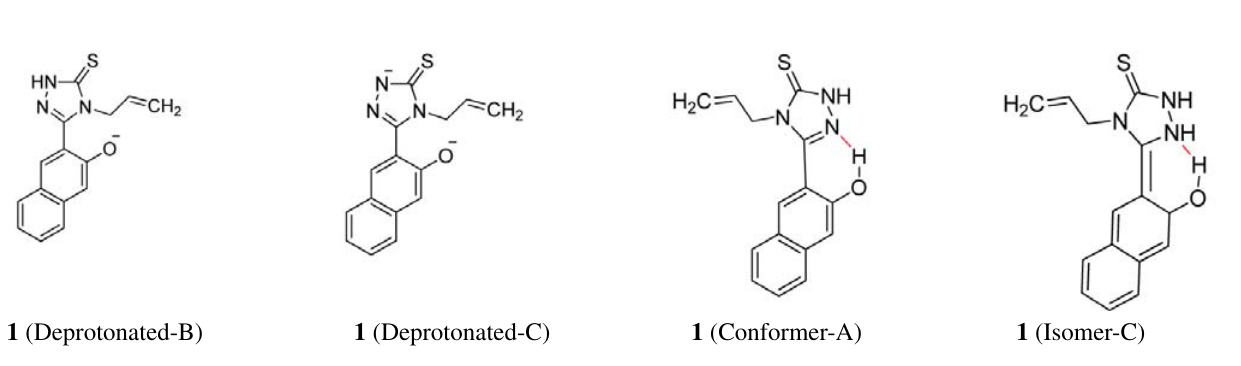
Figure 3. Neutral, deprotonated and tautomeric structures of 1